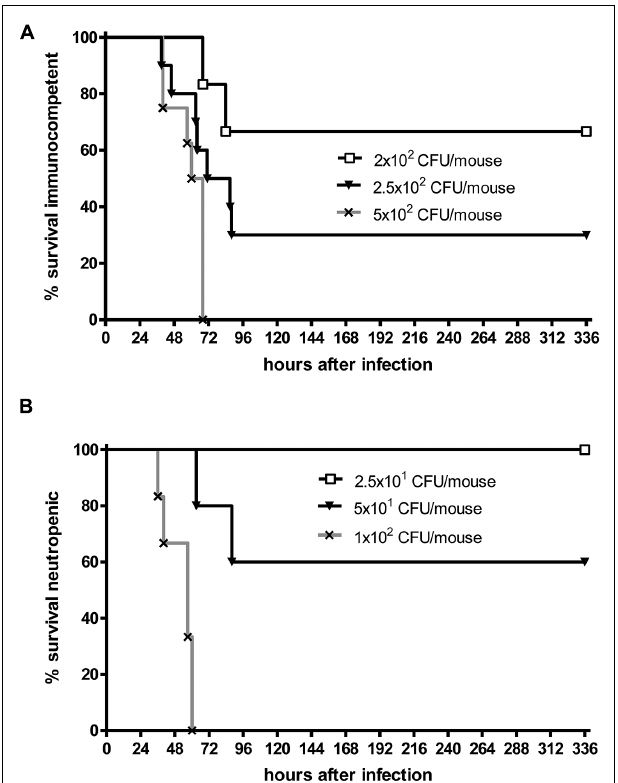
FIGURE 2 | Kaplan–Meier survival curves after intracerebral injection of different numbers of Streptococcus pneumoniae D39 (kindly provided by Prof. Dr. Sven Hammerschmidt, University of Greifswald, Germany). (A) C57Bl/6 immunocompetent mice, (B) C57Bl/6 mice rendered neutropenic with 50 μ g of an anti-Ly-6G monoclonal antibody (1A8 clone). Meningitis was induced by bacterial inoculation into the right frontal neocortex under anesthesia. Please note that 70% of immunocompetent mice survived an intracerebral injection of 200 colony-forming units (CFU). Conversely, all neutropenic mice were killed by an intracerebral inoculum of 100 CFU in less than 3 days suggesting that microglia need the cross-talk with granulocytes across the blood–brain barrier to function properly (Sandra Ribes, unpublished data).